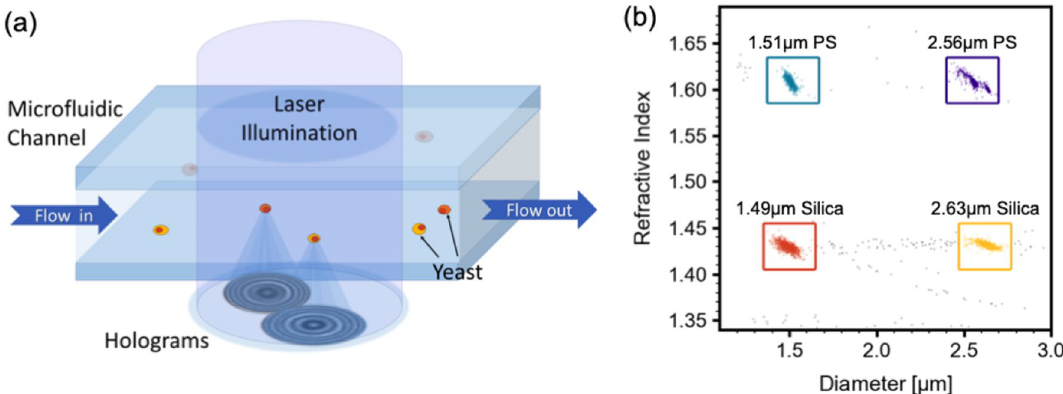
Figure 1. ( a ) A schematic of holographic video microscopy: as cells flow through a microfluidic chip, they are illuminated by a laser beam. Light scattered by the particles interferes with the incident light, forming holograms which are recorded on a camera. ( b ) A scatter plot of size on the horizontal axis and refractive index on vertical axis for 4 species of particles: 1.51 µ m diameter polystyrene spheres (in cyan), 2.56 µ m diameter polystyrene spheres (in violet), 1.49 µ m diameter silica spheres (in orange), 2.63 µ m diameter silica spheres (in yellow). Each point on the plot represents a single particle detected with THC during measurement. The colored boxed are user-defined regions of interest. Particles outside of the 4 user-defined boxes are colored